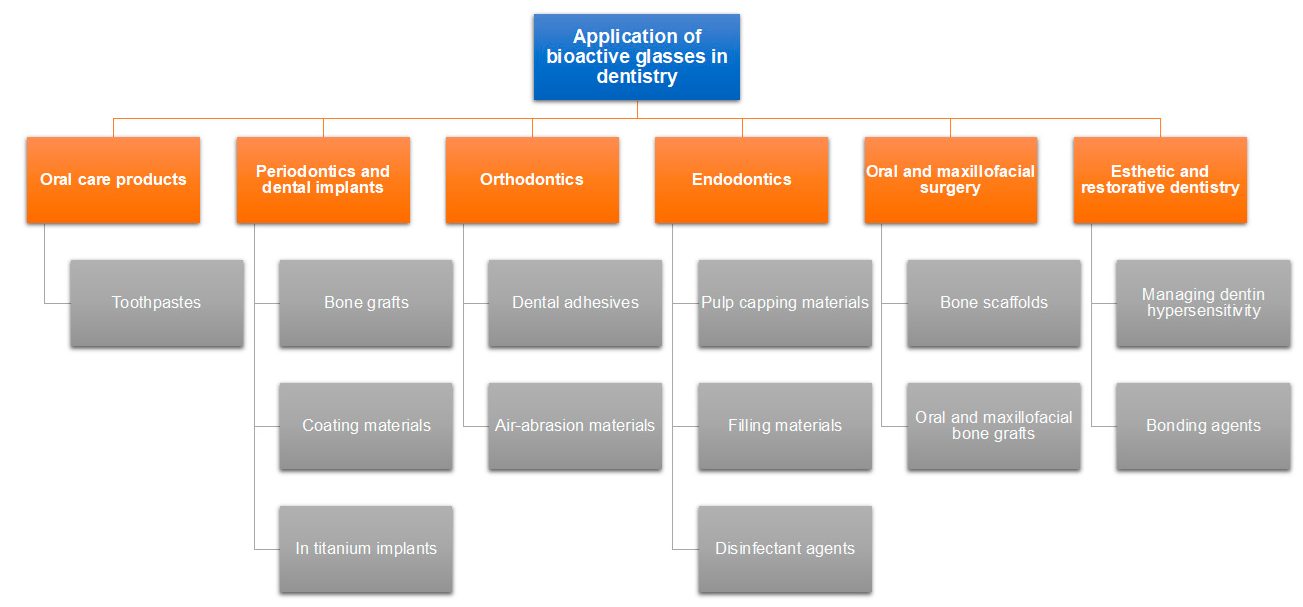
Figure 1. Applications of bioactive glasses in dentistry [16] .